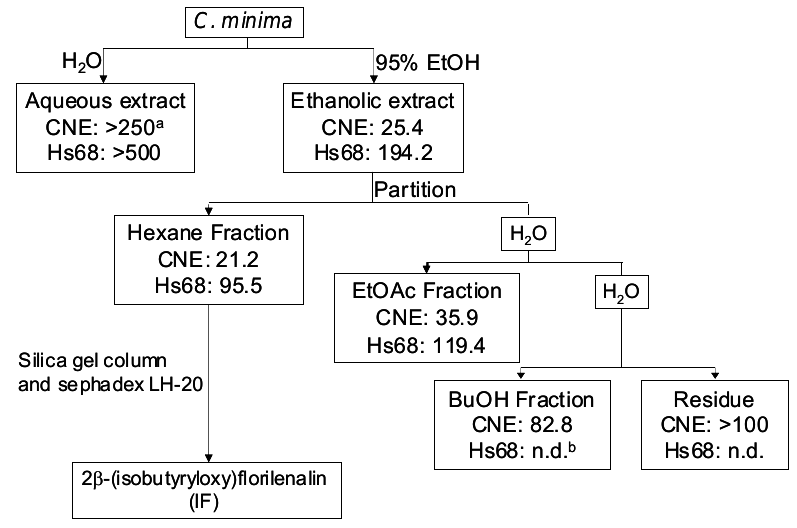
Scheme 1. Summary of the bioactivity-guided isolation of Centipeda minima by using CNE (human nasopharyngeal cancer cells) and Hs68 (human normal skin cells) cells at 72- h treatment. a Inhibition concentration (IC ) value in μ g/mL. b not determined. 50